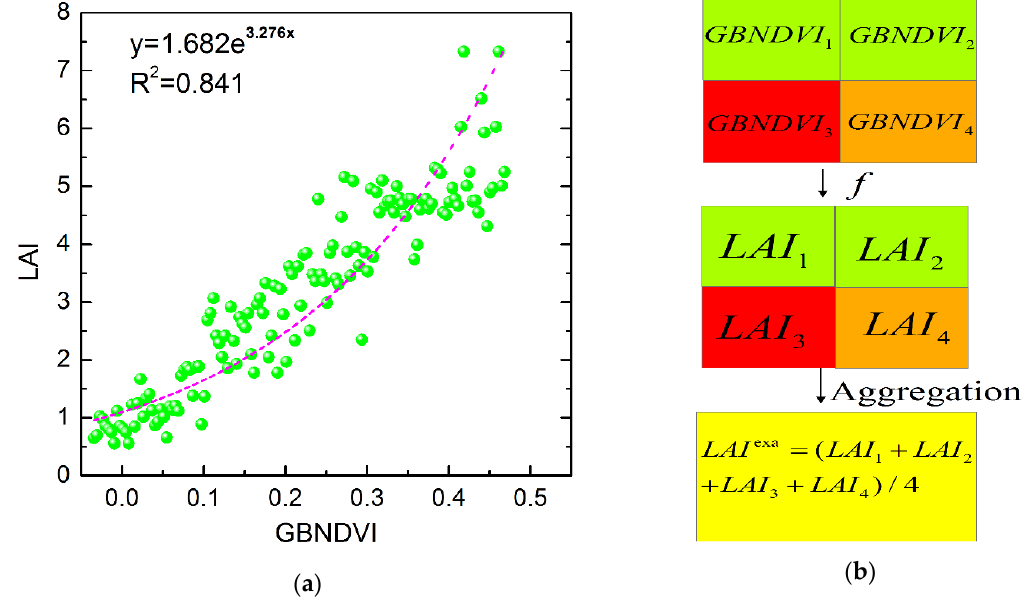
Figure 3. ( a ) Statistical model between the green–blue normalized difference vegetation index (GBNDVI) derived from GF-1 image data and in situ measured leaf area index (LAI); ( b ) Schematic flowchart of the upscaling methods for LAI estimation; f is an empirical transfer function relating to the LAI and vegetation index GBNDVI i . GBNDVI i ( i = 1, 2, 3, 4) is the high spatial resolution GBNDVI data; LAI i is the corresponding LAI values; LAI exa , which is defined as the average of the LAI i ( i = 1, 2, 3, 4), is the exact LAI value at the coarse spatial resolution.